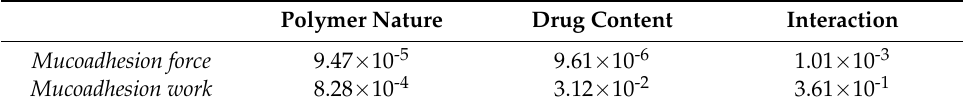
Figure 8. Mucoadhesion force and mucoadhesion work observed for the batches prepared on bovine vaginal mucosa. Table 4. Results of the ANOVA processing of the mucoadhesion forces of the batches; the factors are the nature of the polymer and the drug content. p -values below α = 0.05 indicate no significant